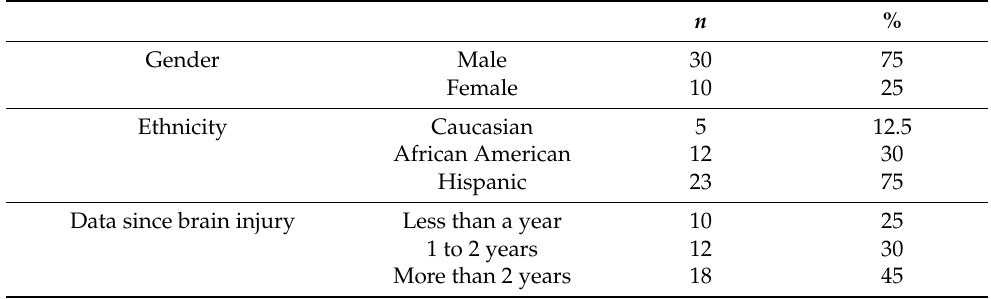
Table 1. Demographic characteristics.